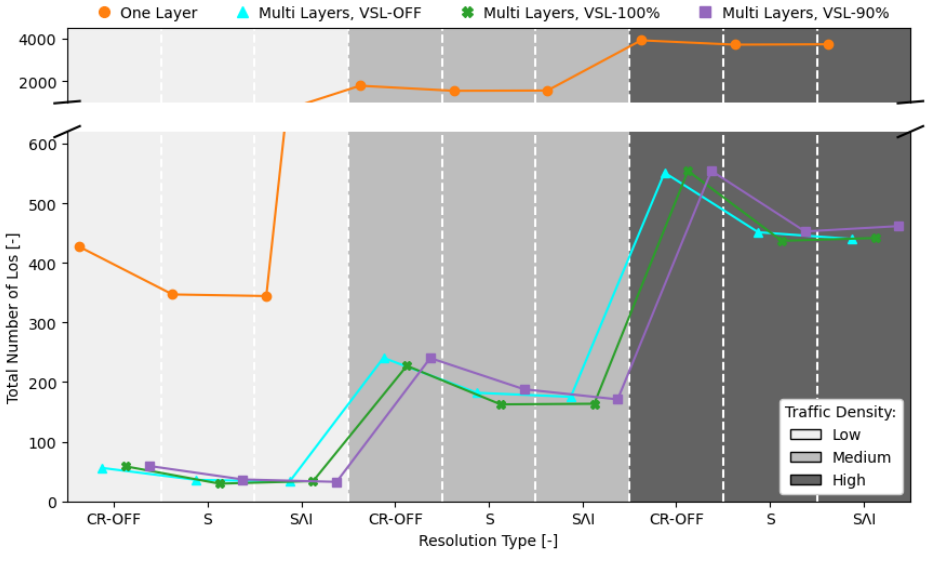
Figure 19. Mean total number of losses of